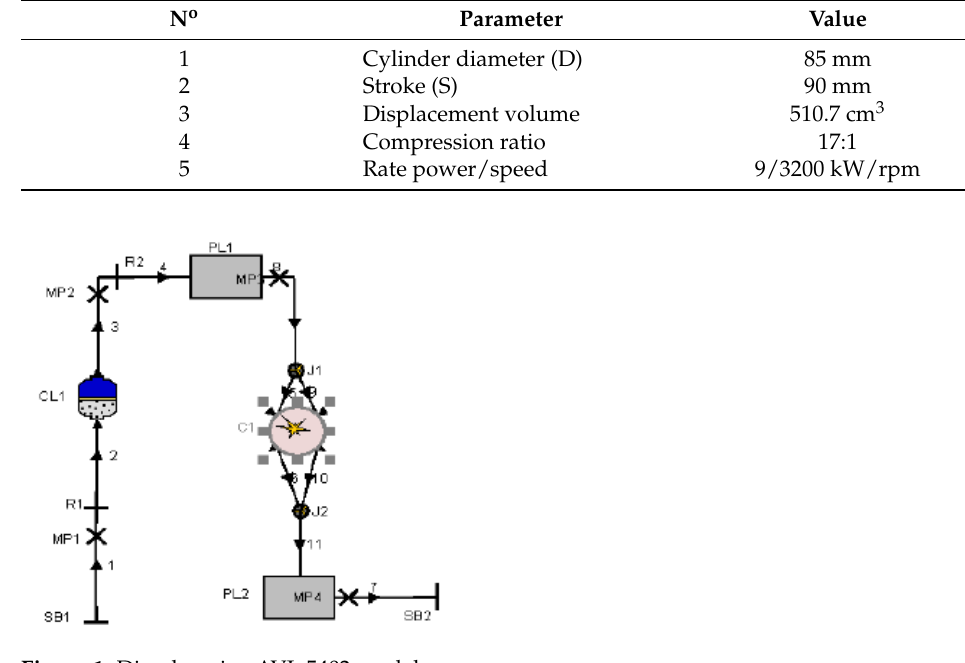
Figure 1. Diesel engine AVL 5402 model. Table 5. Specifications of the engine.